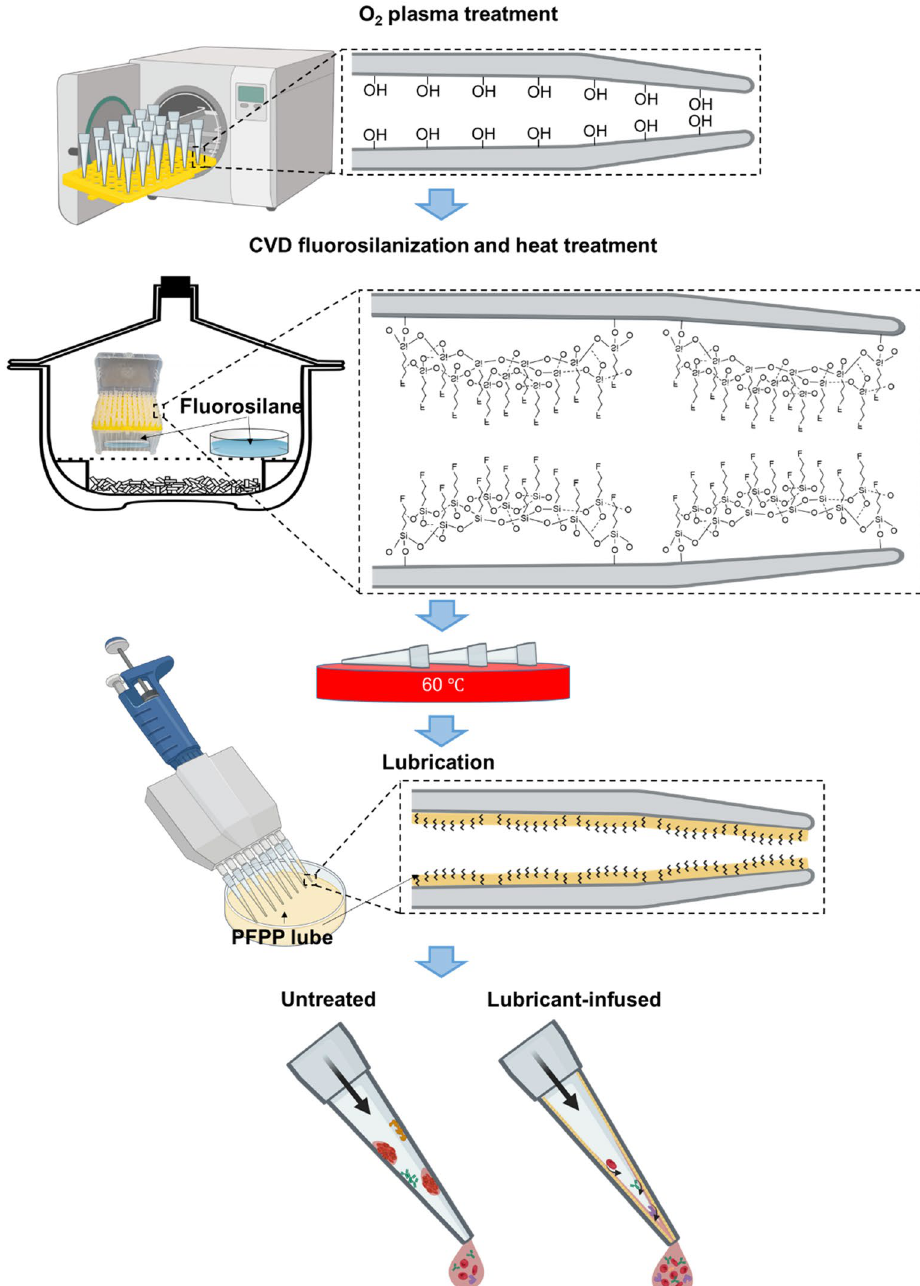
Figure 1. Schematic illustration of the treatment procedure along with the chemical structures of the treated tips at each step of the modification. Pipette tips were oxygen plasma treated followed by CVD treatment with TPFS and heat treatment at 60 °C overnight. The tips were subsequently lubricated via pipetting in and out PFPP lubricant. The lubricant layer can repel different types of biomolecules and solutions whereas in the commercially available tips (untreated tips), biomolecules and reagents can attach to the inner lumen of the tips causing inaccuracies in volumes and